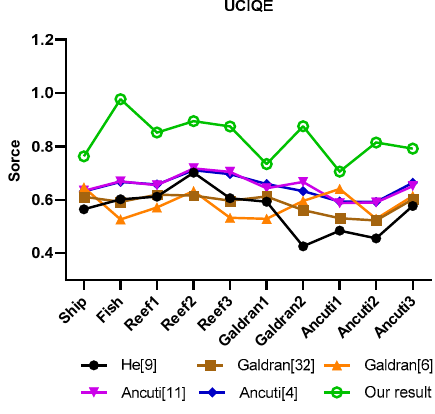
Figure 8. UCIQE metric.